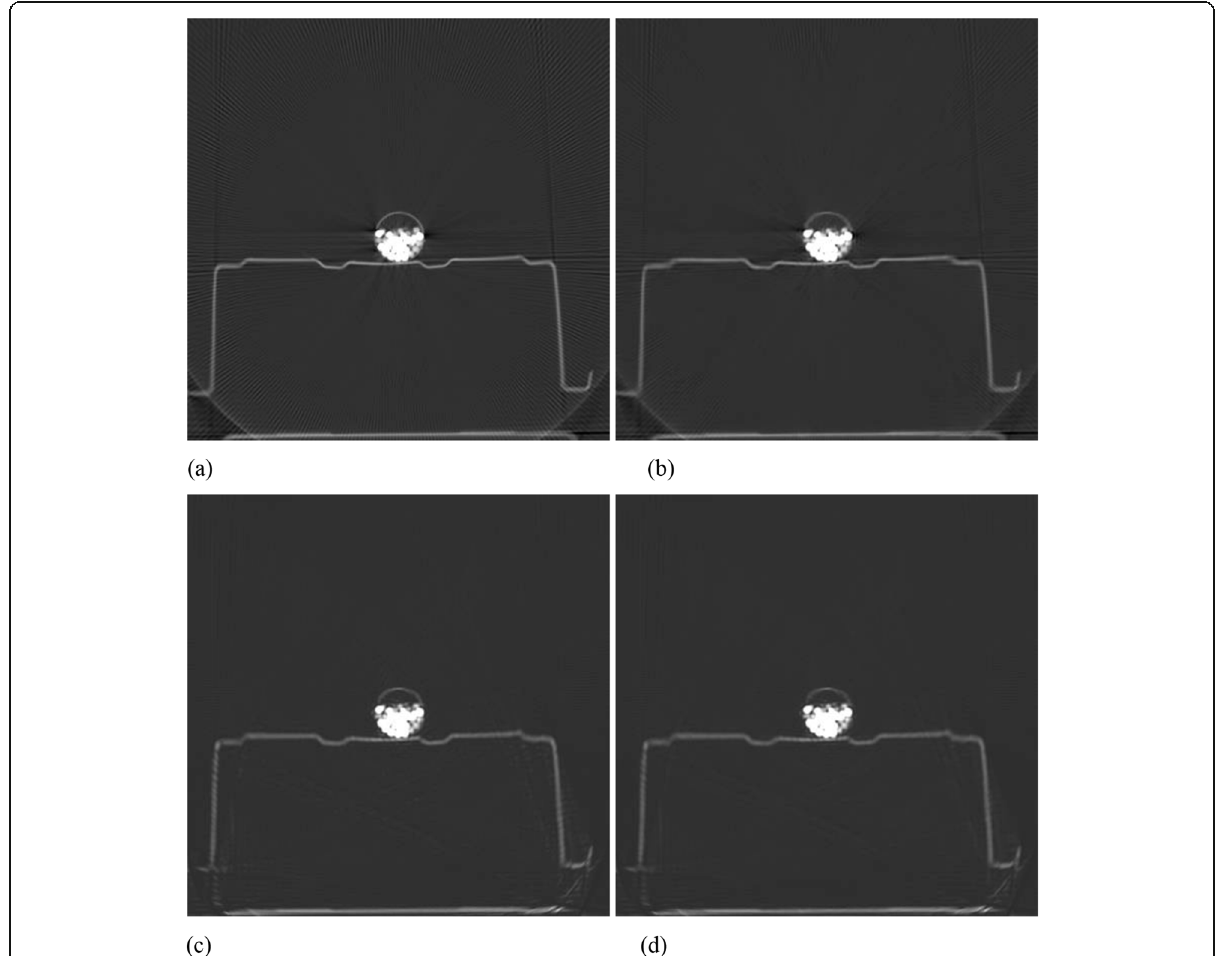
Fig. 6 Reconstruction of bag #5 (New threshold value to segment the metal image and new β 1 = 0.0002). a Raw FBP; b TV-term only; c Non- negativity-term only; d